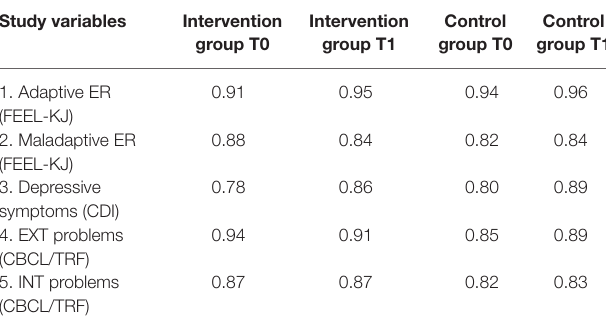
TABLE 3 | Pre- and post-test reliabilities (Cronbach’s α